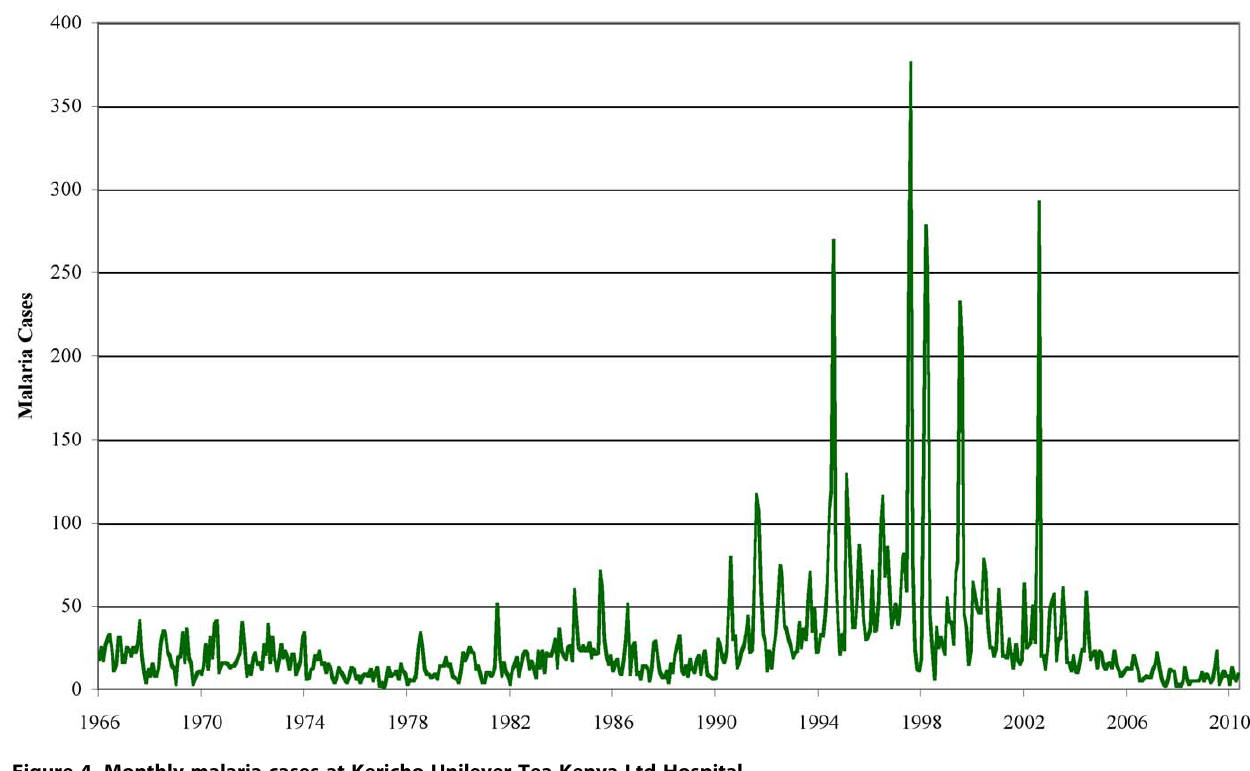
Figure 4. Monthly malaria cases at Kericho Unilever Tea Kenya Ltd Hospital.